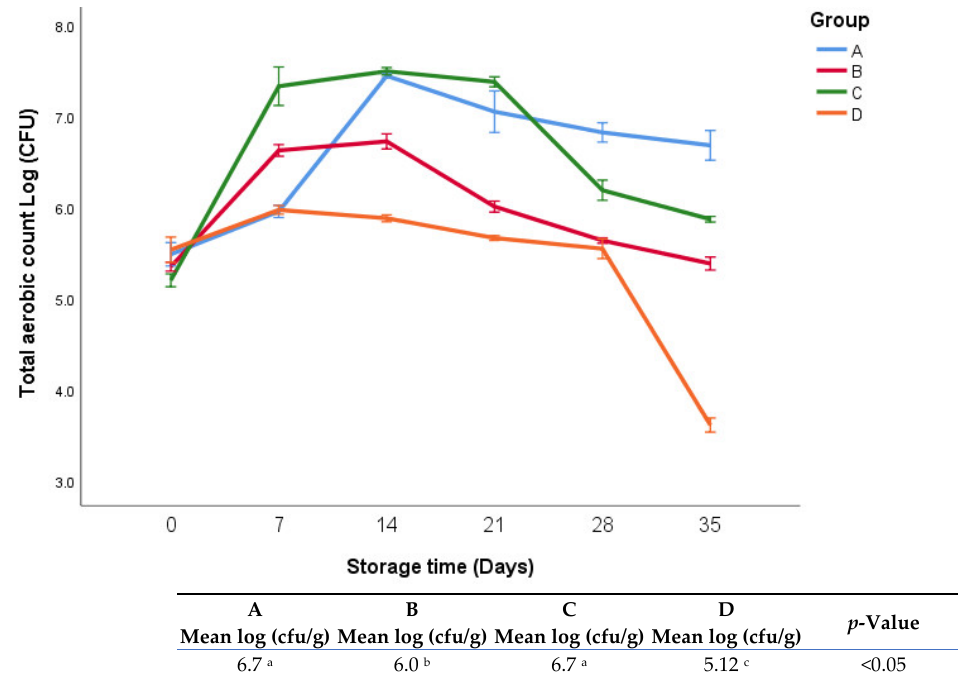
Figure 3. Total aerobic bacterial count of fresh oregano at refrigerator temperature 4 °C during storage period (35 days). The significant differences ( p < 0.05) between means are indicated in different letters in the same row. The effect of treatments was pooled to consider the whole storage period and the means were separated by Duncan test.